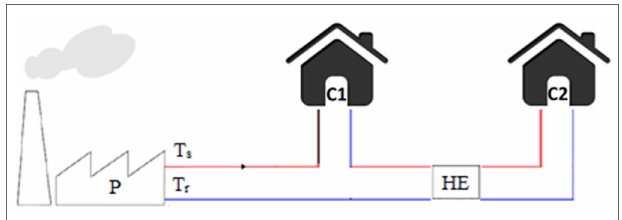
FIGURE 4 | Schematic plan of the DHS with primary and secondary loops